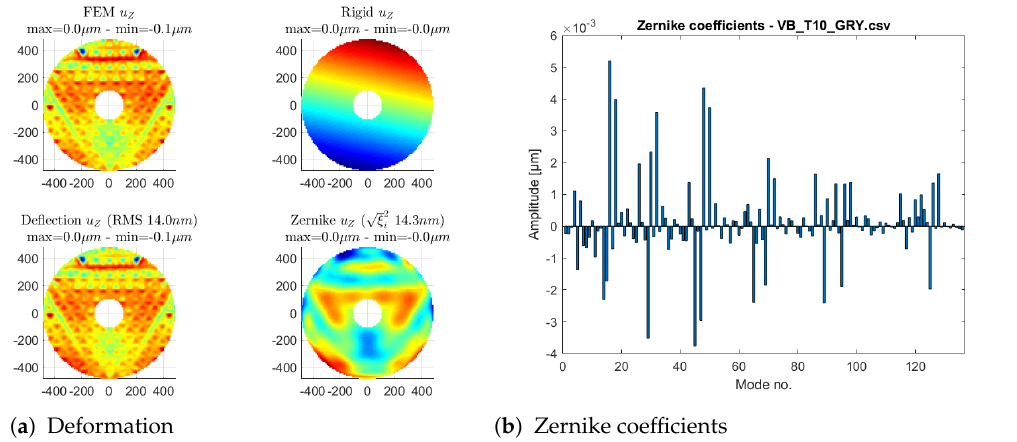
Figure 10. Optimum (optimization conducted on IP responses) and outside support.